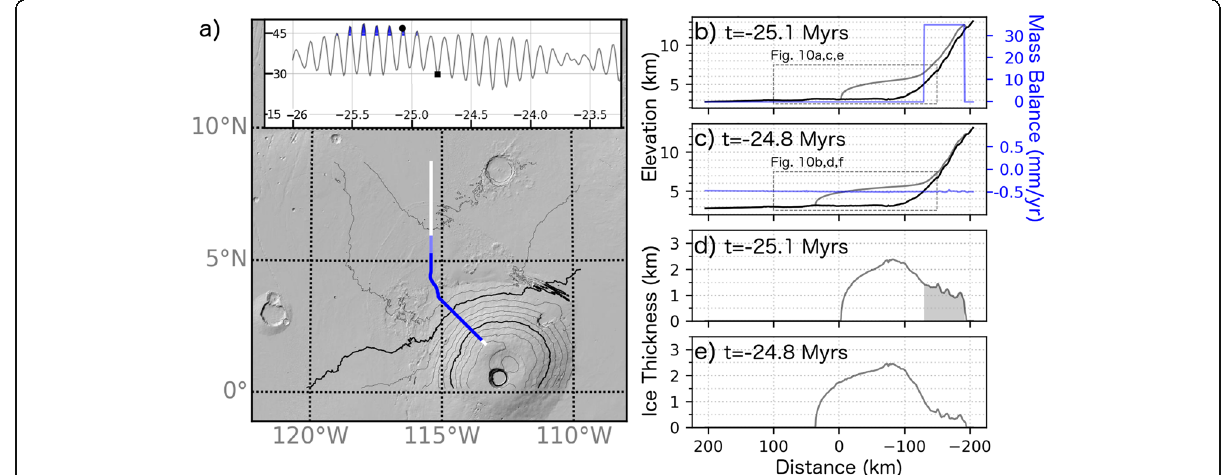
Fig. 6 Model snapshots illustrating assumptions regarding the timing and location of ice accumulation. Inset plot shows obliquity history at the beginning of the simulations with time and obliquity on x and y axes, respectively. Precipitation occurs at times indicated by the filled blue regions (see Fig. 6). a MOLA hillshade contour (1 km interval) map indicating location of model flowline (white line) and extent of ice in the model (transparent blue lines) at − 25.1 (circle in inset) and − 24.8 Myr (square in inset). Topographic profiles of the ice deposit at − 25.1 and − 24.8 Myr are shown in b and c , respectively with the blue line (and right y-axis) indicating ice accumulation/ablation rate. Ice thickness for these times are shown in d and e with the shaded region in d indicating extent of ice